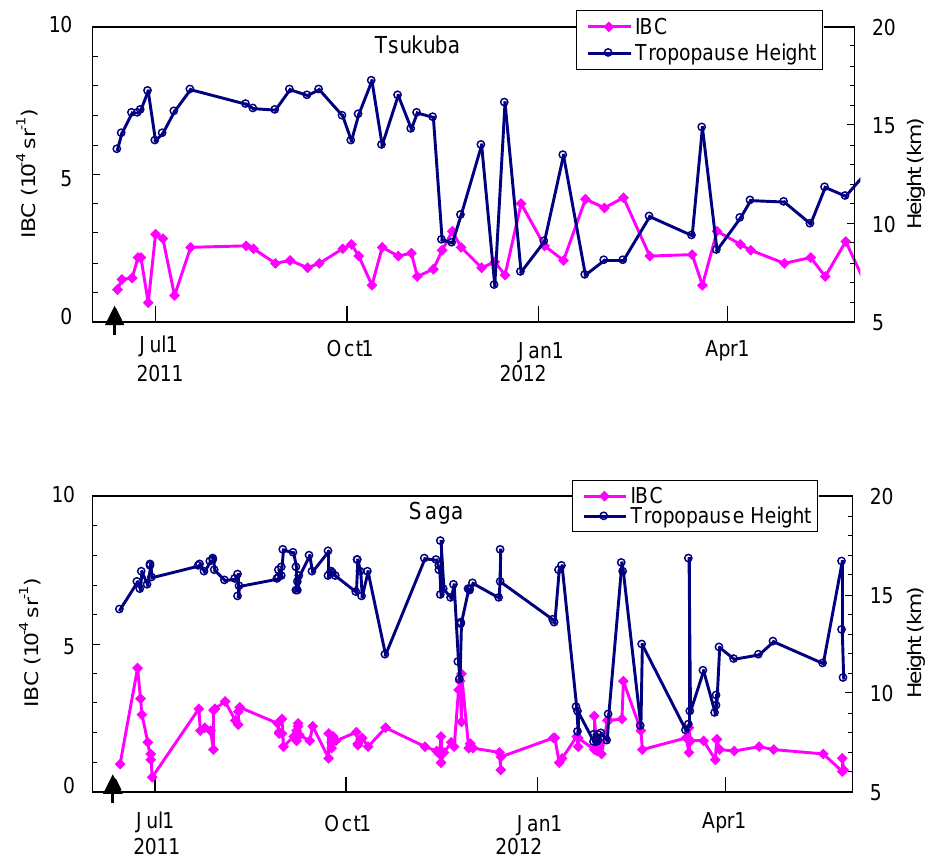
Fig. 5. Temporal variation of the integrated backscattering coefficient (IBC) from the first tropopause to an altitude of 33km (pink solid diamond) and first tropopause height (blue open circle) over Tsukuba (upper panel) and Saga (lower panel) from June 2011 to May 2012.